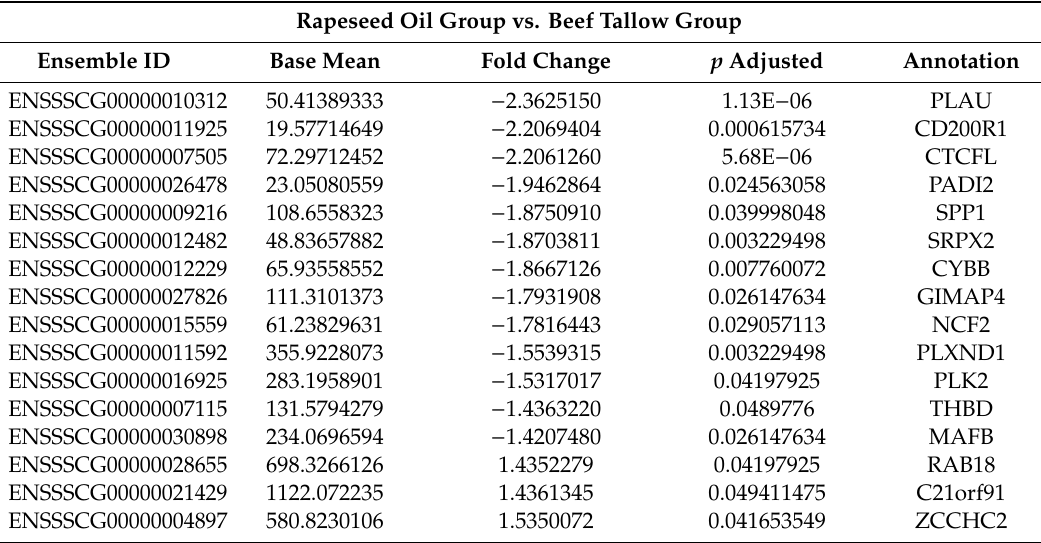
Table 1. Di ff erentially expressed genes identified in the